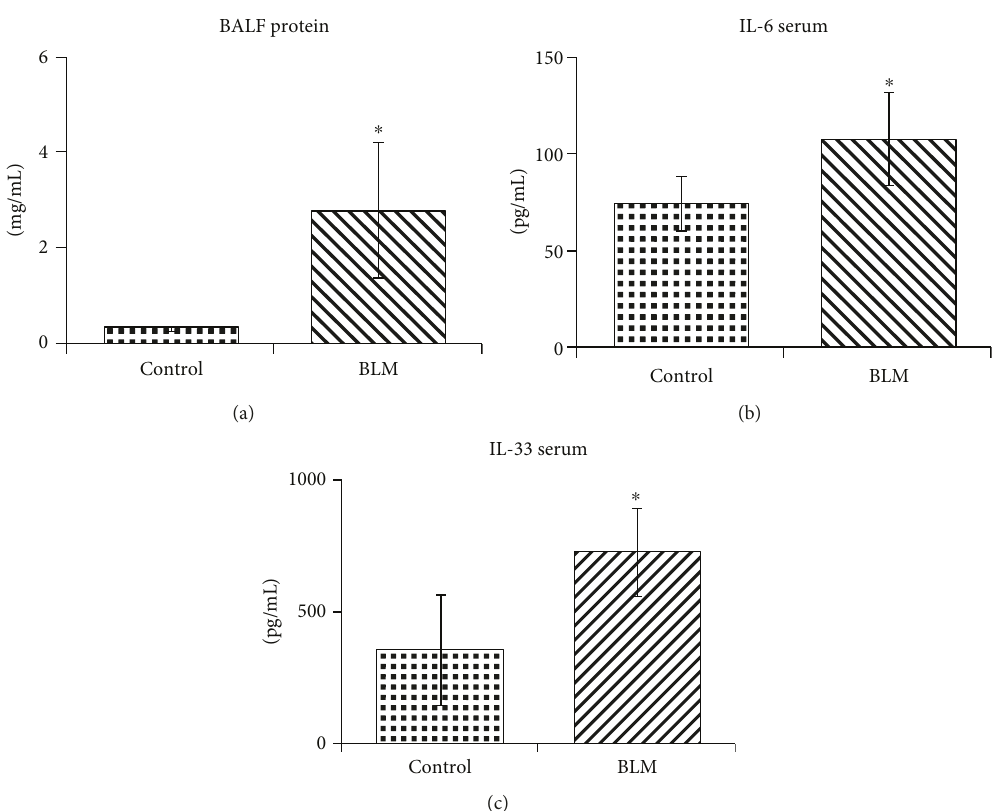
Figure 4: The circulation of IL-6 and IL-33 was increased in mice with BLM-induced lung fi brosis. (a) Protein levels in bronchoalveolar lavage fl uid (BALF) were estimated by using a BCA kit assay. The cytokines in mouse serum were measured by ELISA. (b) IL-6. (c) IL-33. Light spots represent the cytokine amount in control mice ( n = 4 ), and dark spots represent the cytokine amount in mice with BLM-induced lung injury ( n = 5 ). The quantitative data were expressed as the means ± SD . ∗ p < 0 05 compared with